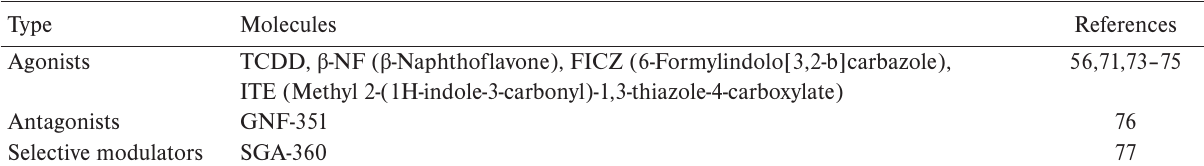
Table 1. Selected AHR ligands divided into agonists, antagonists and selective modulators. Type